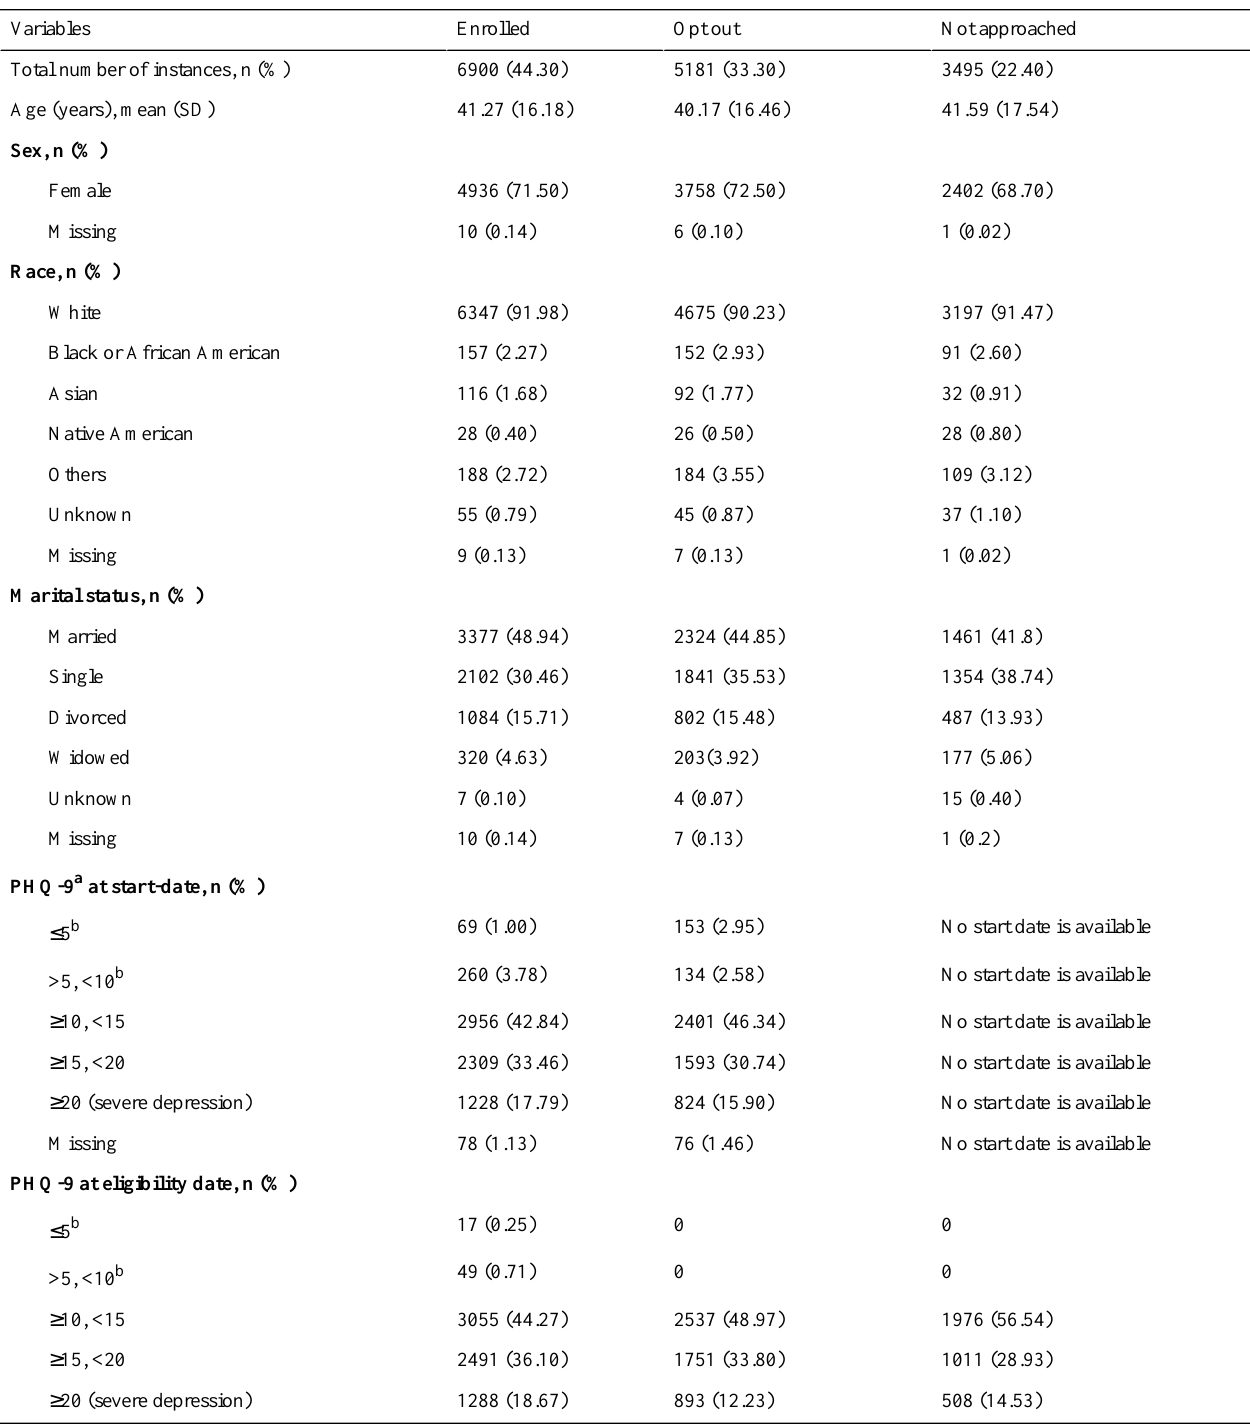
Table 4. Statistics on major patient subgroups in the depression registry.